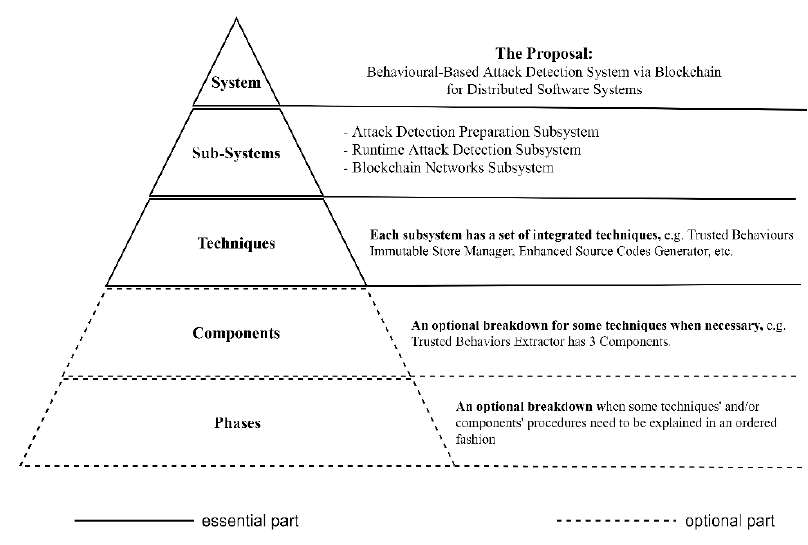
Figure 3. Overview of the proposal and its breakdowns in a hierarchical structure.